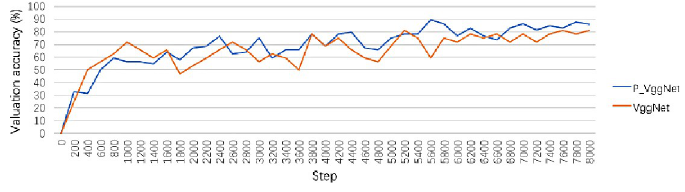
Fig 7. Validation accuracy curve of P_VggNet and